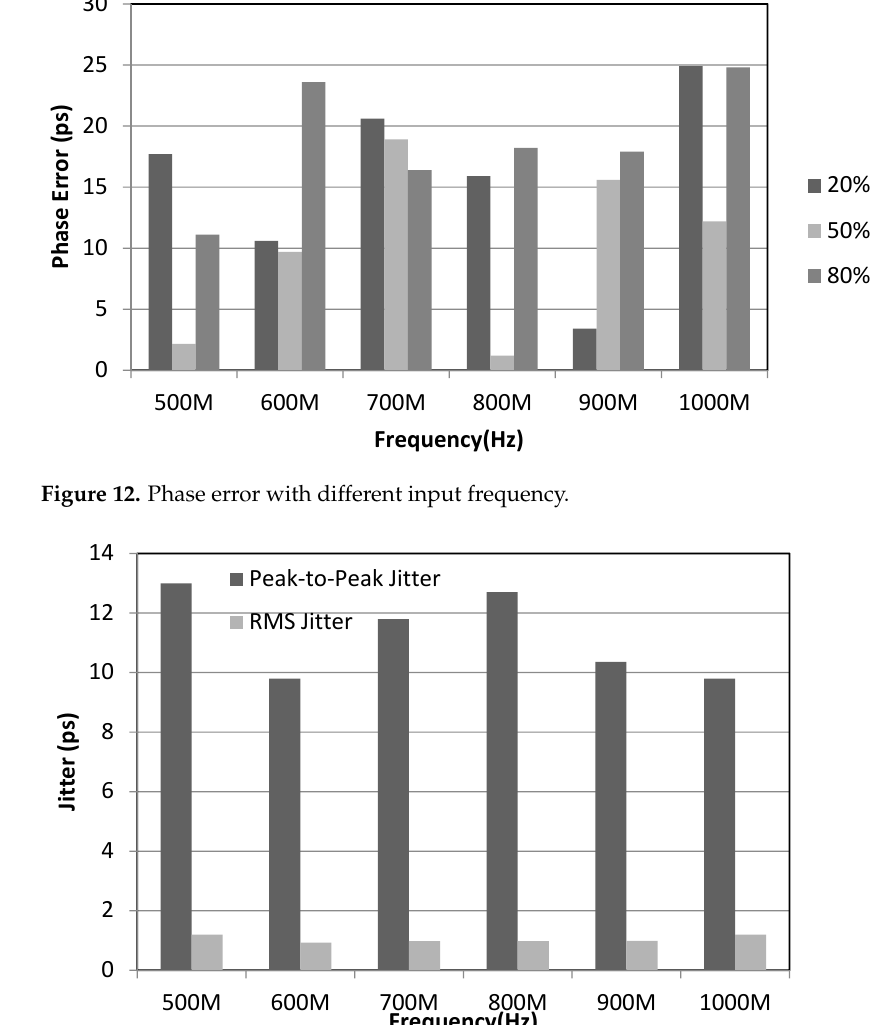
Figure 13. Peak-to-Peak Jitter and RMS jitter with different input frequency.